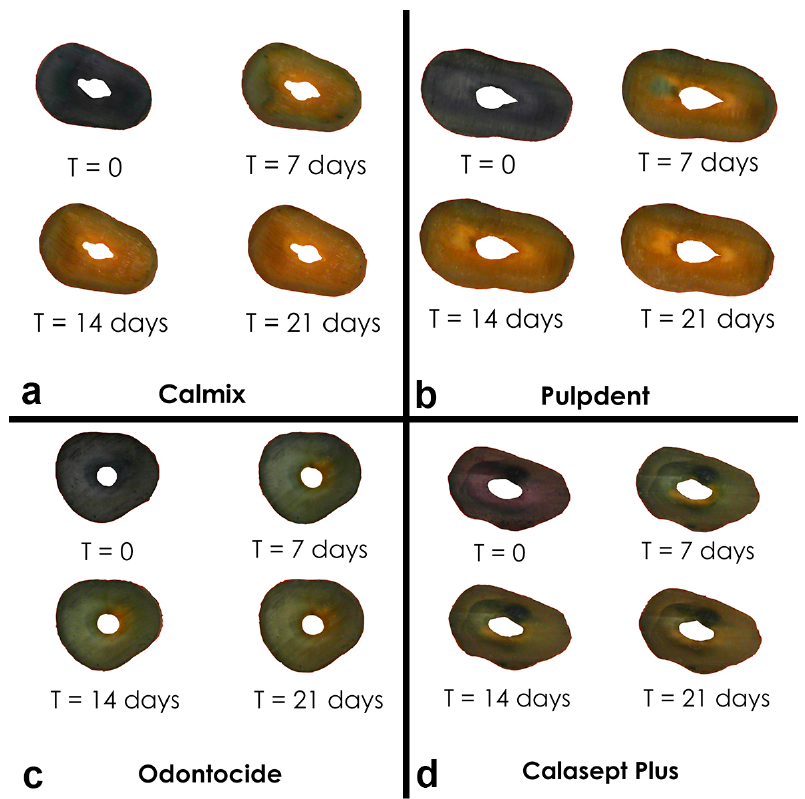
Figure 3. Image sequence of the coronal root surface of a set of roots treated with different commercial medicaments over time.